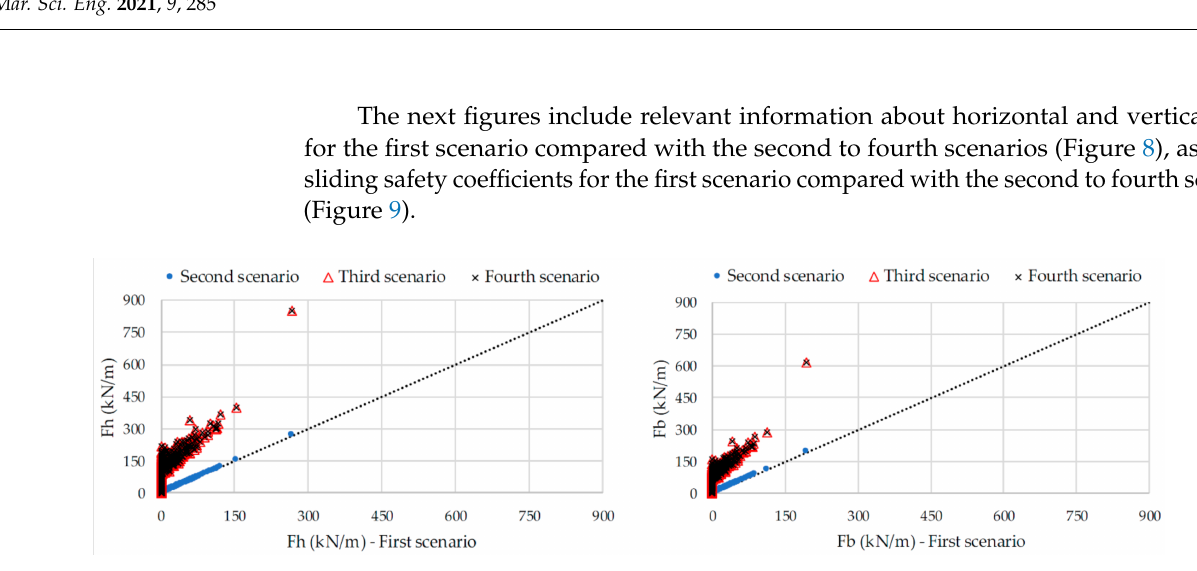
Figure 8. Horizontal and vertical forces for the first scenario compared with the second to fourth scenarios.